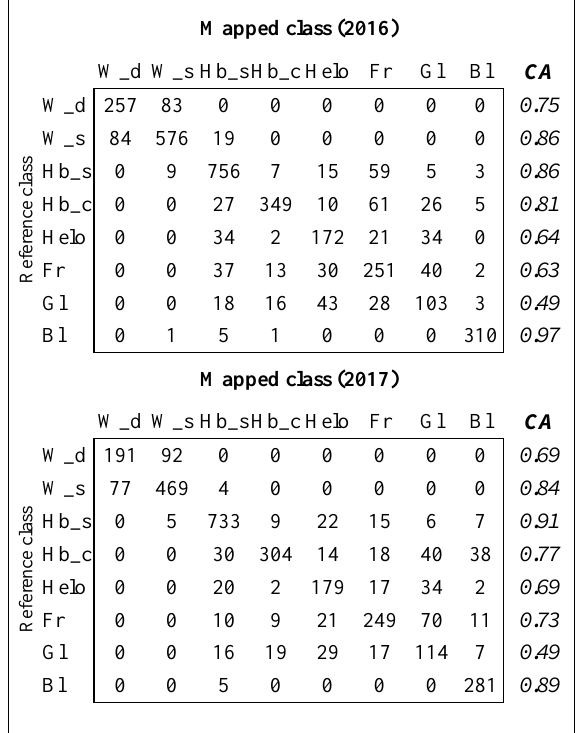
Table 2 . Confusion matrix of the vegetation community type maps calculated on the independent validation sets for 2016 (upper panel) and 2017 (lower panel). W_d: Water (opt. deep); W_s: Water (opt. shallow); Hb_s: Herbaceous (salt marsh); Hb_c: Herbaceous (coastal); Helo: Helophytes; Fr: Forest (coastal); Gl: Grassland; Bl: Barren